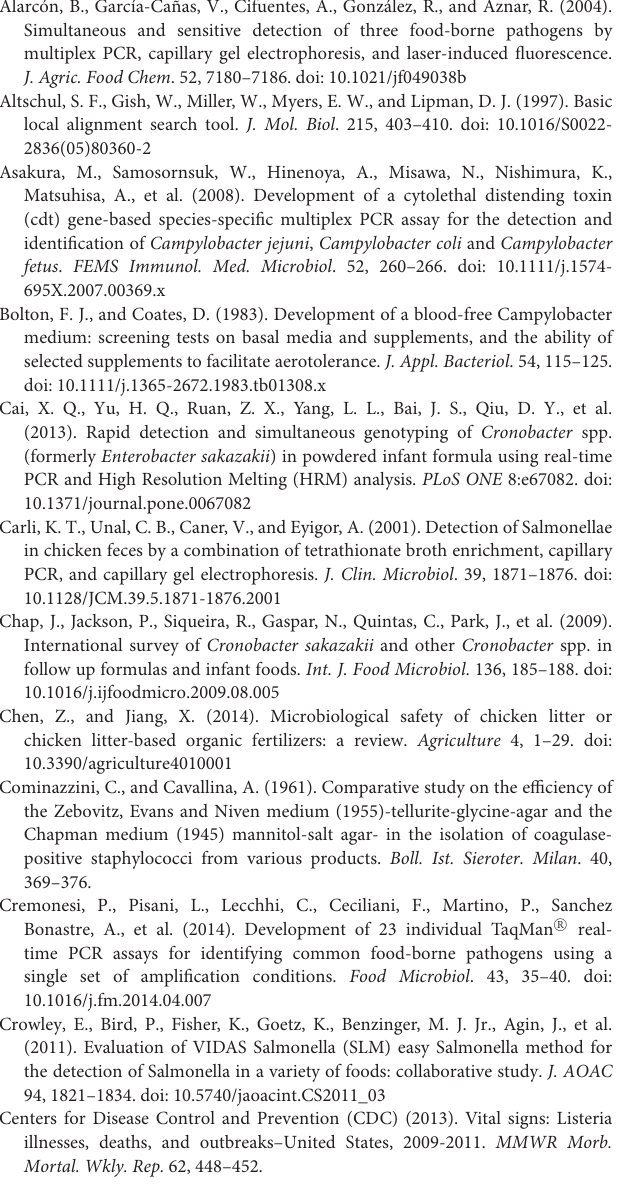
Figure S2 | Amplicons obtained by mPCR for different strains of the tested bacterial species. Values showed on peak’s top corresponds to the size detected for each amplicon in bp. B. cereus strains: CECT-193, 83535, 34588, 53591, 83536, 83537, HUCA-431. L. monocytogenes strains: CECT-7467, 41319, 31925, 883, 103545-4, 61318, HUCA-17. St. aureus strains: CECT-435, 5083, 51555,